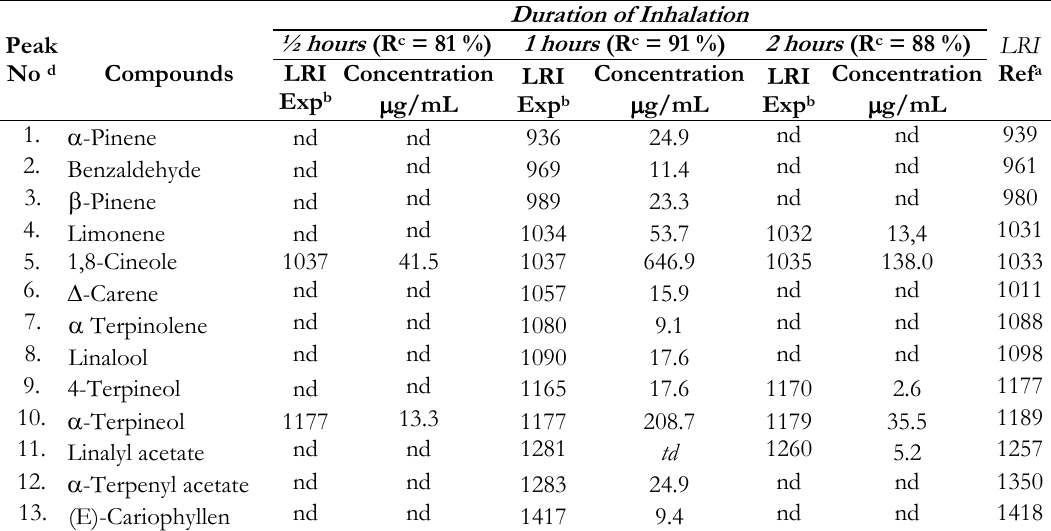
Table I. Essential compounds identified in blood plasma of mice after the inhalation of nutmeg seed oil with SPE C-18 preparation, analyzed by GC-MS. Peak